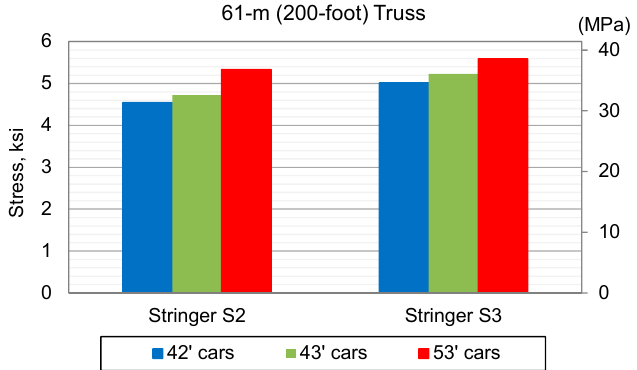
Figure 16. Typical peak stress calculated from measured strains, comparisons for stringers. The effect of railcar length on stringers was also visible when evaluating stress ranges.